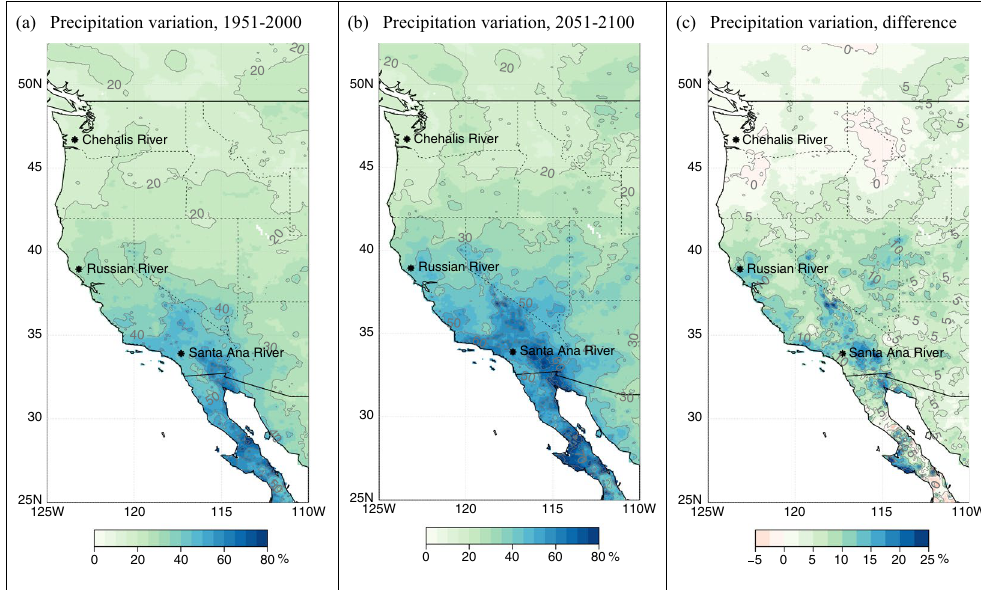
Figure 3. Coefficient of variation (i.e. variance normalized by the mean) of de-trended * annual total precipitation during historical ( a ) and future ( b ) time periods in the Real-5 LOCA-downscaled GCM ensemble average, and the difference ( c ). * 150-year polynomial trend was previously removed from the precipitation data (see Section